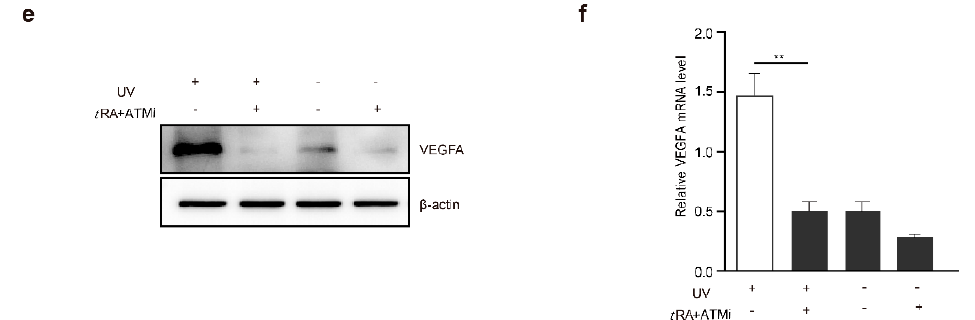
Figure 7. ATM inhibitor greatly improved the effect of t RA to inhibit the growth of a melanoma xenograft in mice. ( a ) Schematic diagram of the experimental procedure for the xenograft model in C57BL/6 mice. ( b ) Representative tumor images are shown. ( c ) Tumor growth and ( d ) body weight curves of the mice treated with UV and t RA/KU-55933 and the controls. ( e ) Western blot analysis of VEGFA expression in tumor tissues from mice treated with UV and t RA/KU-55933 and the controls. ( f ) RT-PCR analysis of VEGFA mRNA levels in tumor tissues from the mice mentioned above. All values above are shown as means ± SEM ( n = 8, ** p < 0.01).